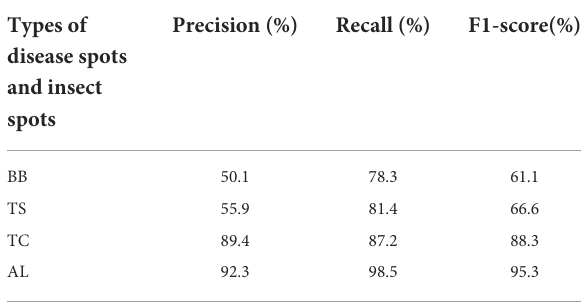
TABLE 2 Mask R-CNN model recognition results of disease spots and insect